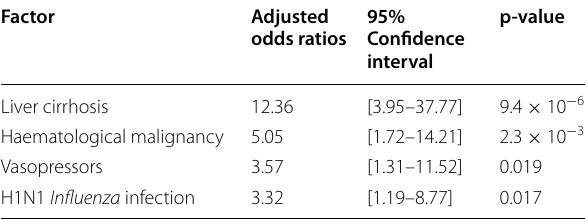
Table 1. Factors associated with Aspergillosis‑positive lower res‑ piratory tract specimen culture in multivariate